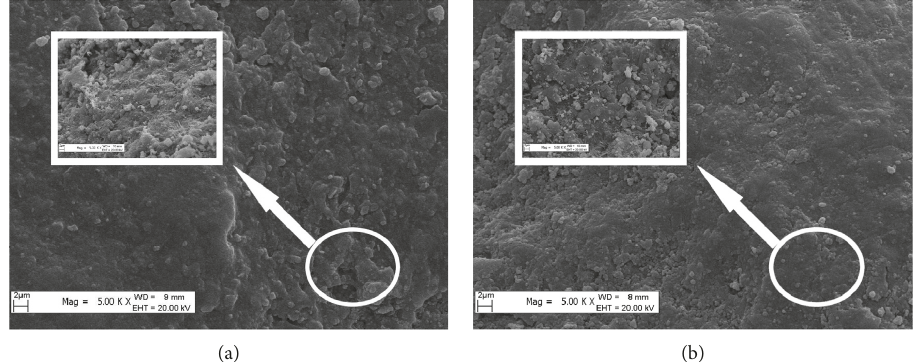
Figure 8: Pore enlargement of (a) RCC-30-20 and (b) RCC-30-25 in the experimental group.